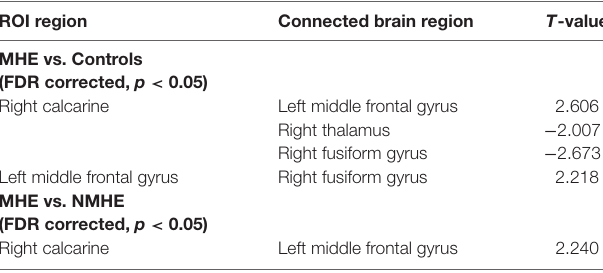
connectivity (FC) between patients with and without MHE and healthy controls